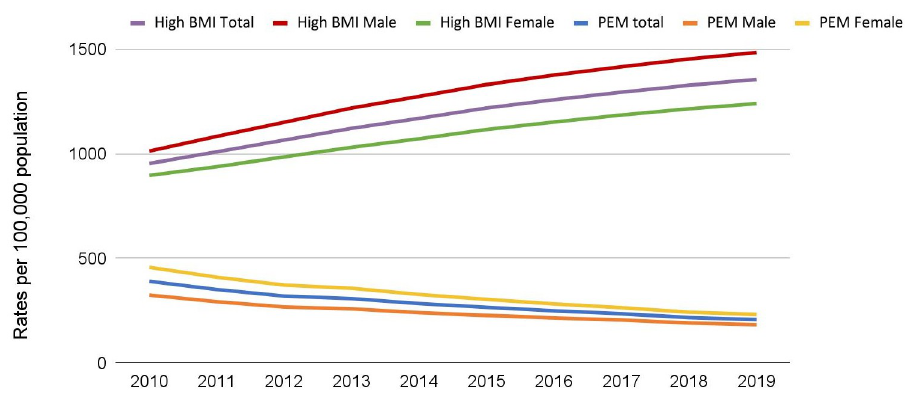
Fig 1. Trend of DALY for Protein Energy Malnutrition and High Body Mass Index in Nepal (2010–2019).